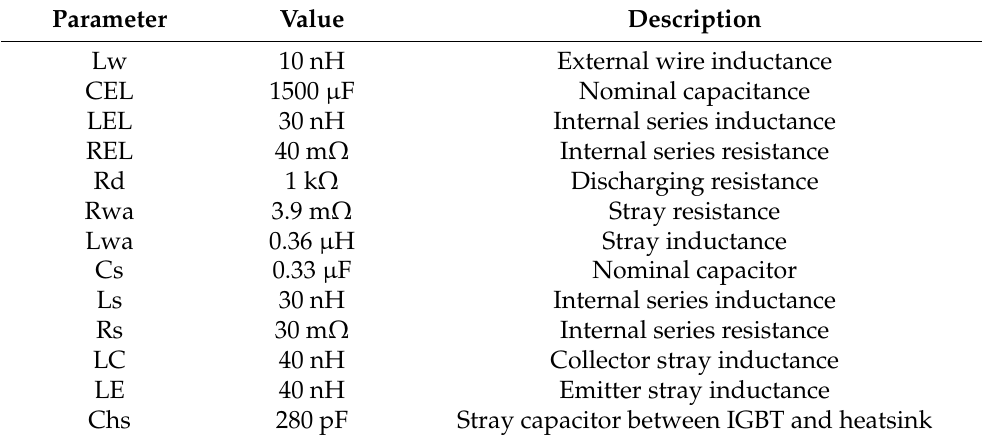
Table A1. Parameters of the inverter model in Figure